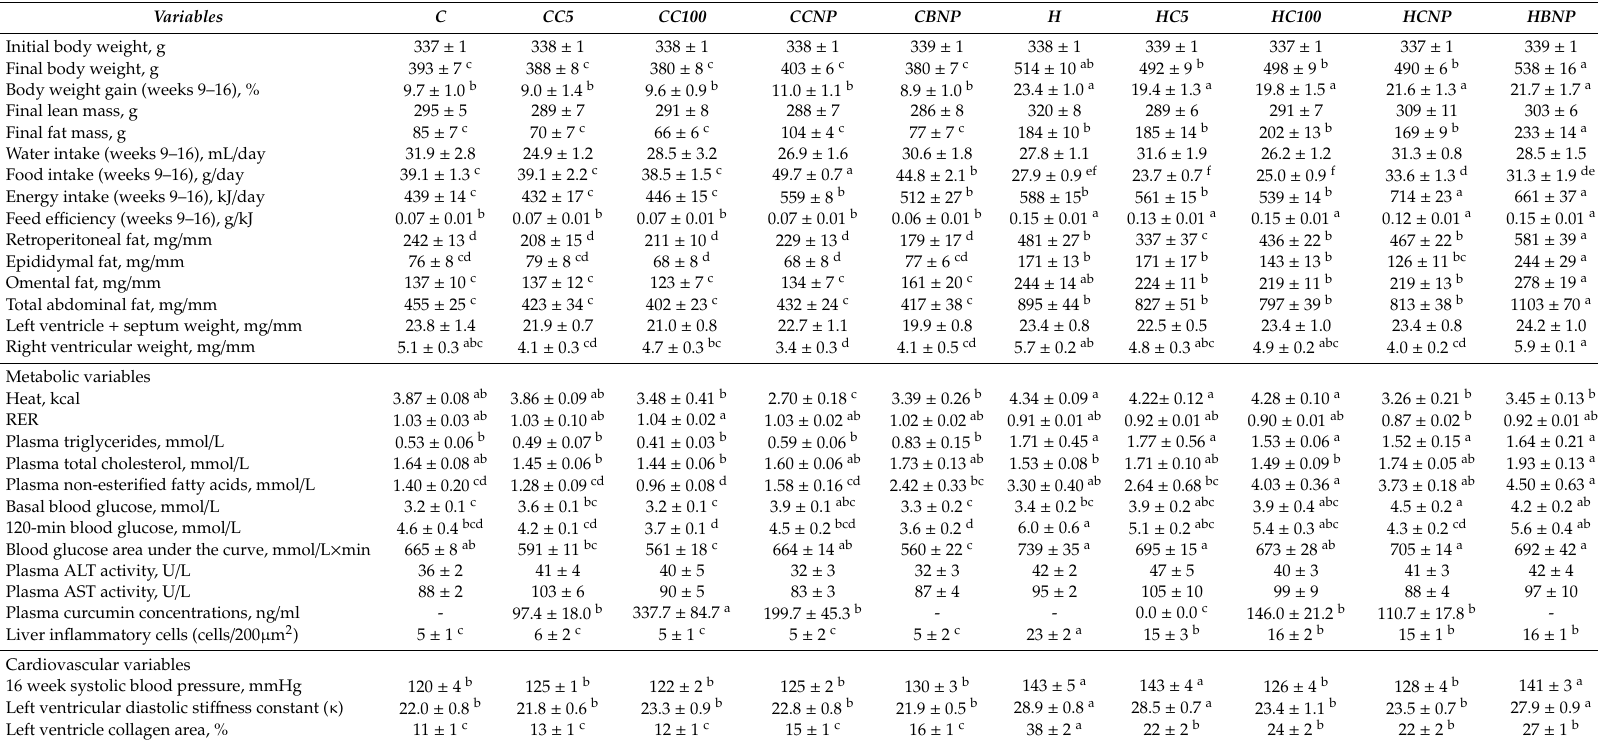
Table 1. Responses to curcumin and curcumin